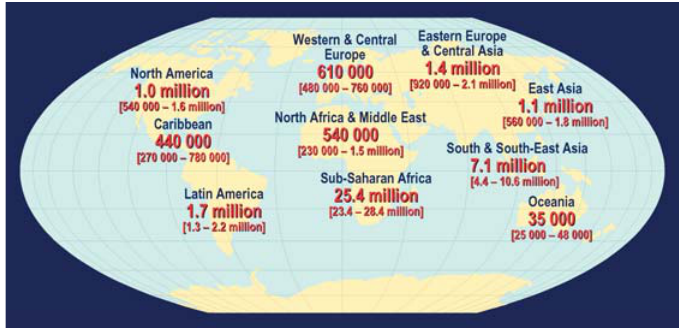
Figure 1. Adults and Children Estimated to Be Living With HIV as of the End of 2004 (Total: 39.4 [35.9–44.3]